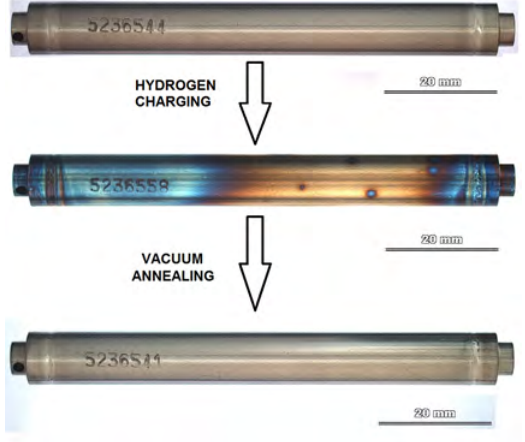
Figure 5. The typical outlook of specimen before and after vacuum annealing process.